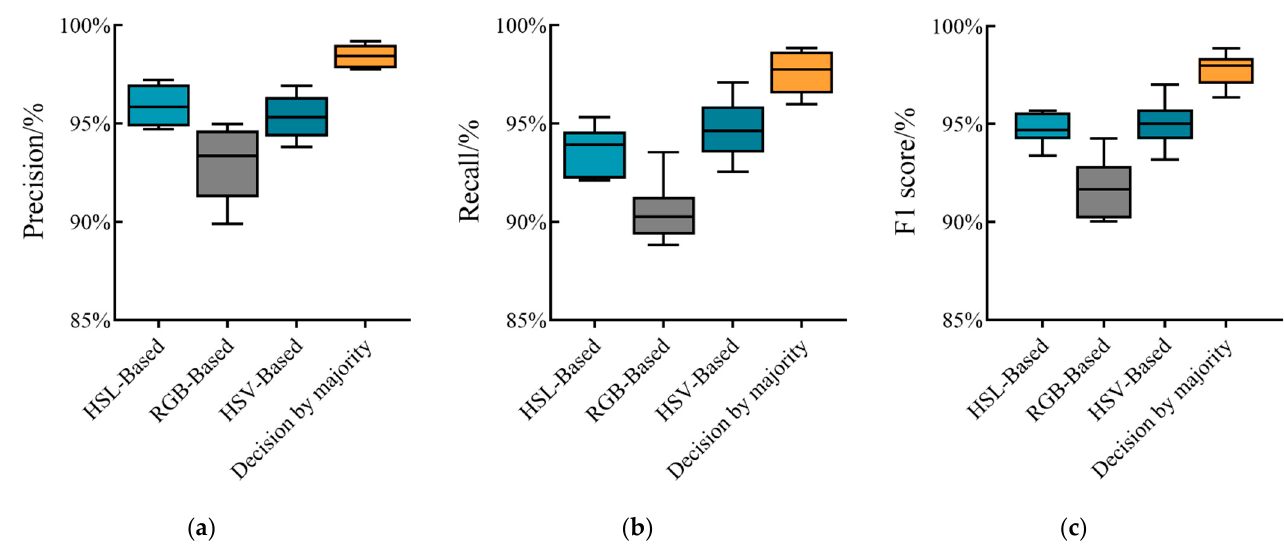
Figure 26. Test results of image identification methods. ( a ) Precision. ( b ) Recall. ( c ) F 1 score.